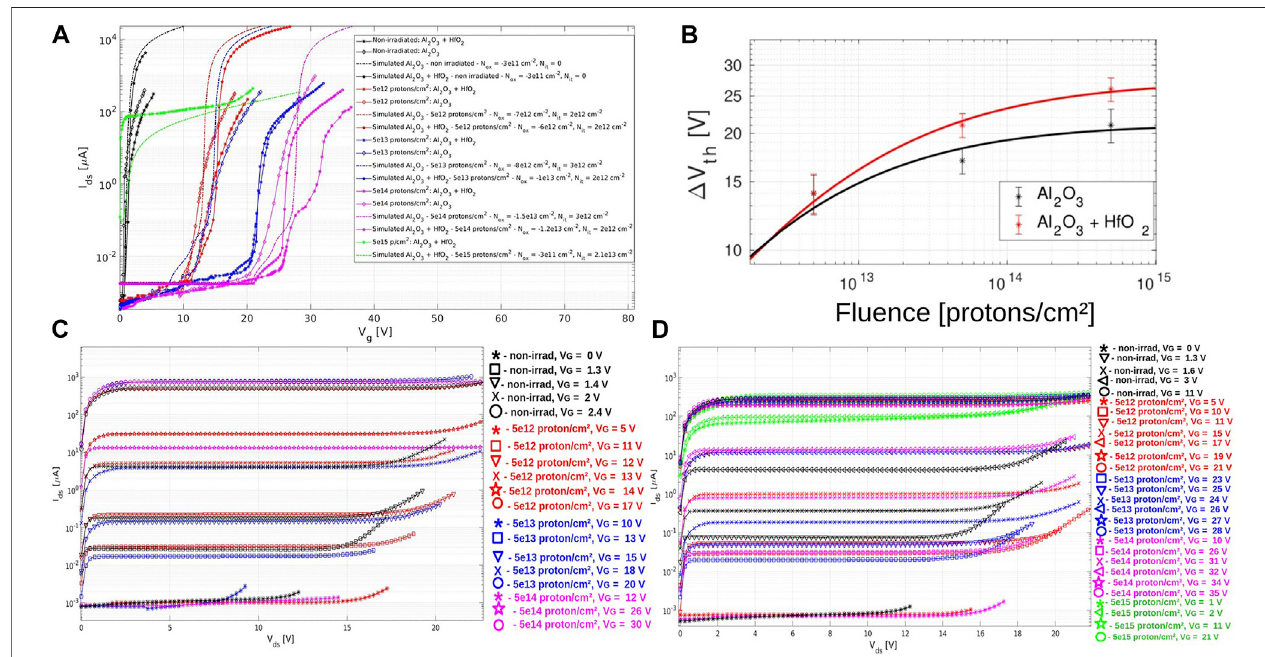
FIGURE 6 | (A) Measured and TCAD simulated transfer characteristics and variation of drain-source current (I ds ) with gate voltage (V g ) for pre- and post – proton- irradiated MOSFETs with different dielectrics, at a constant drain-to-source voltage of 1 V. (B) Change in the shift in threshold voltage ( Δ V th ) with fl uence for proton- irradiated MOSFETs with different oxides. Output characteristics and variation of I ds with V ds , measured at varying V g values for non-irradiated and irradiated MOSFETs with (C) Al 2 O 3 and (D) Al 2 O 3 + HfO 2 as the dielectric